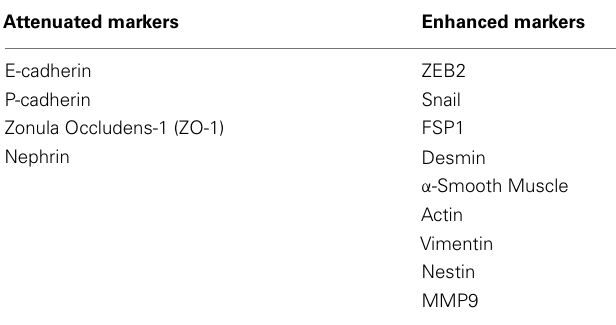
Table 1 | List of EMT markers that either decrease or increase in podocytes upon treatment with GH andTGF- β 1